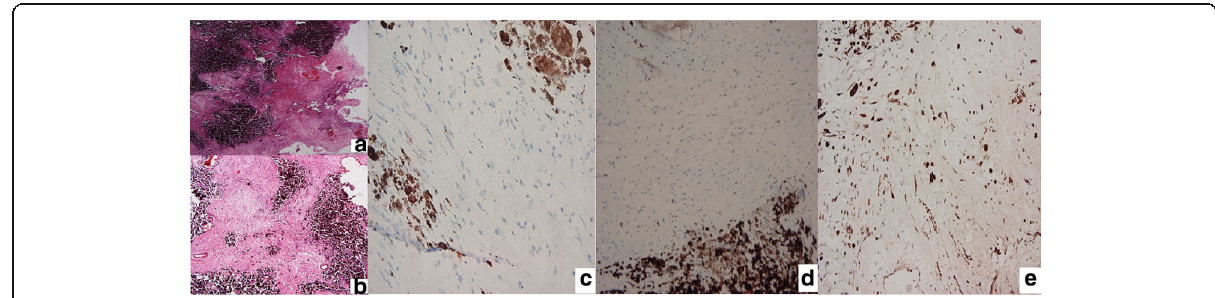
Fig. 2 Images a (× 40) and b (× 100) are hematoxylin and eosin-stained slides showing tumor formed of epithelioid and spindle cells mostly masked by dense brown pigment deposition. Immunohistochemistry: negative for epithelial membrane antigen (EMA) ( c ). Less than 1% of tumor cells are stained for Ki67 ( d ). Tumor cells are focally positive for S100 ( e